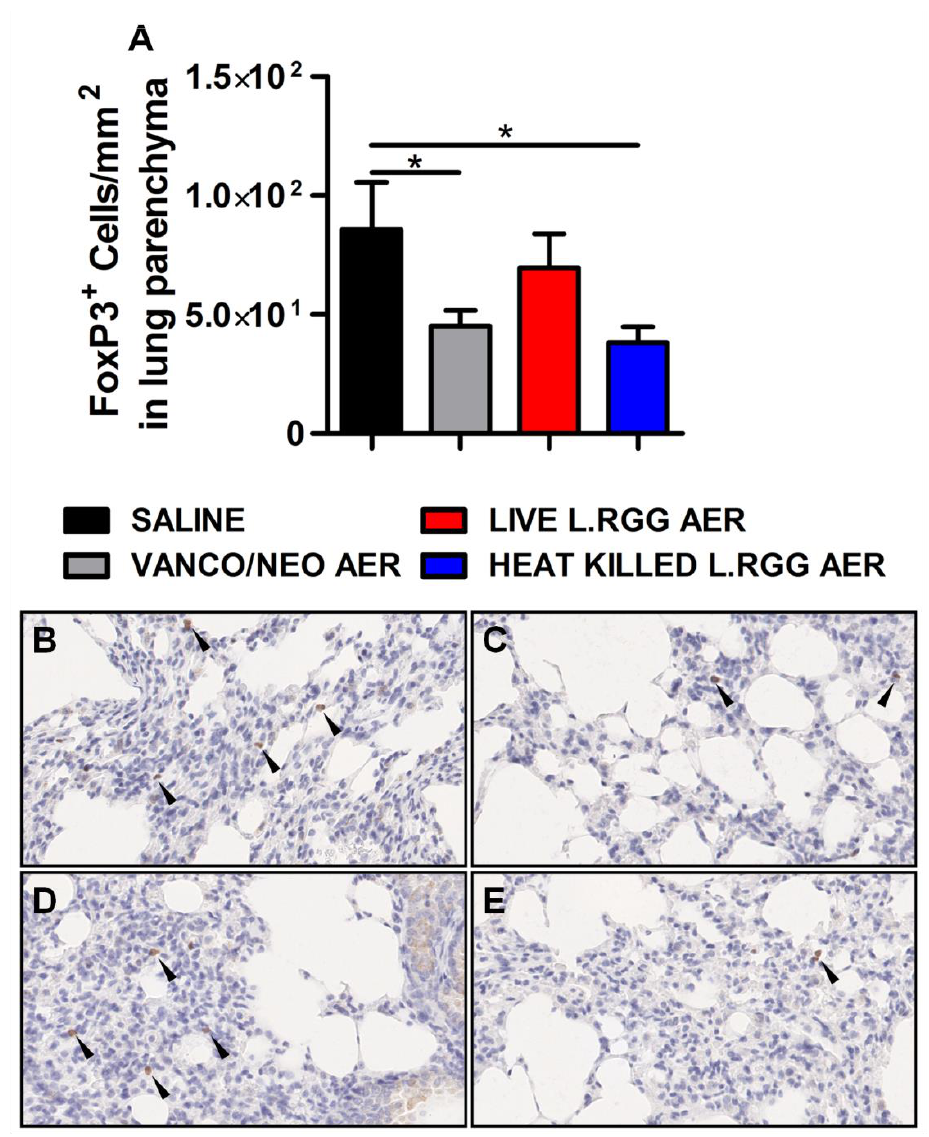
Figure 2. Effect of antibiotics and probiotic aerosol therapy on lung infiltrating T regs. ( A ) FoxP3 protein level in formalin-fixed, paraffin-embedded lung parenchyma specimens evaluated by IHC analysis (4 section/lung, 8 – 9 mice/group) (mean ± SEM). Data are expressed as positive cells/mm 2 . Representative staining with anti-mouse FoxP3 antibody in ( B ) saline-, ( C ) vanco/neo-, ( D ) live L.RGG- and ( E ) heat-killed L.RGG- treated lungs are shown. Arrows indicate FoxP3 + cells; 40 × magnification. * p ≤ 0.05 by unpaired Student t -test.